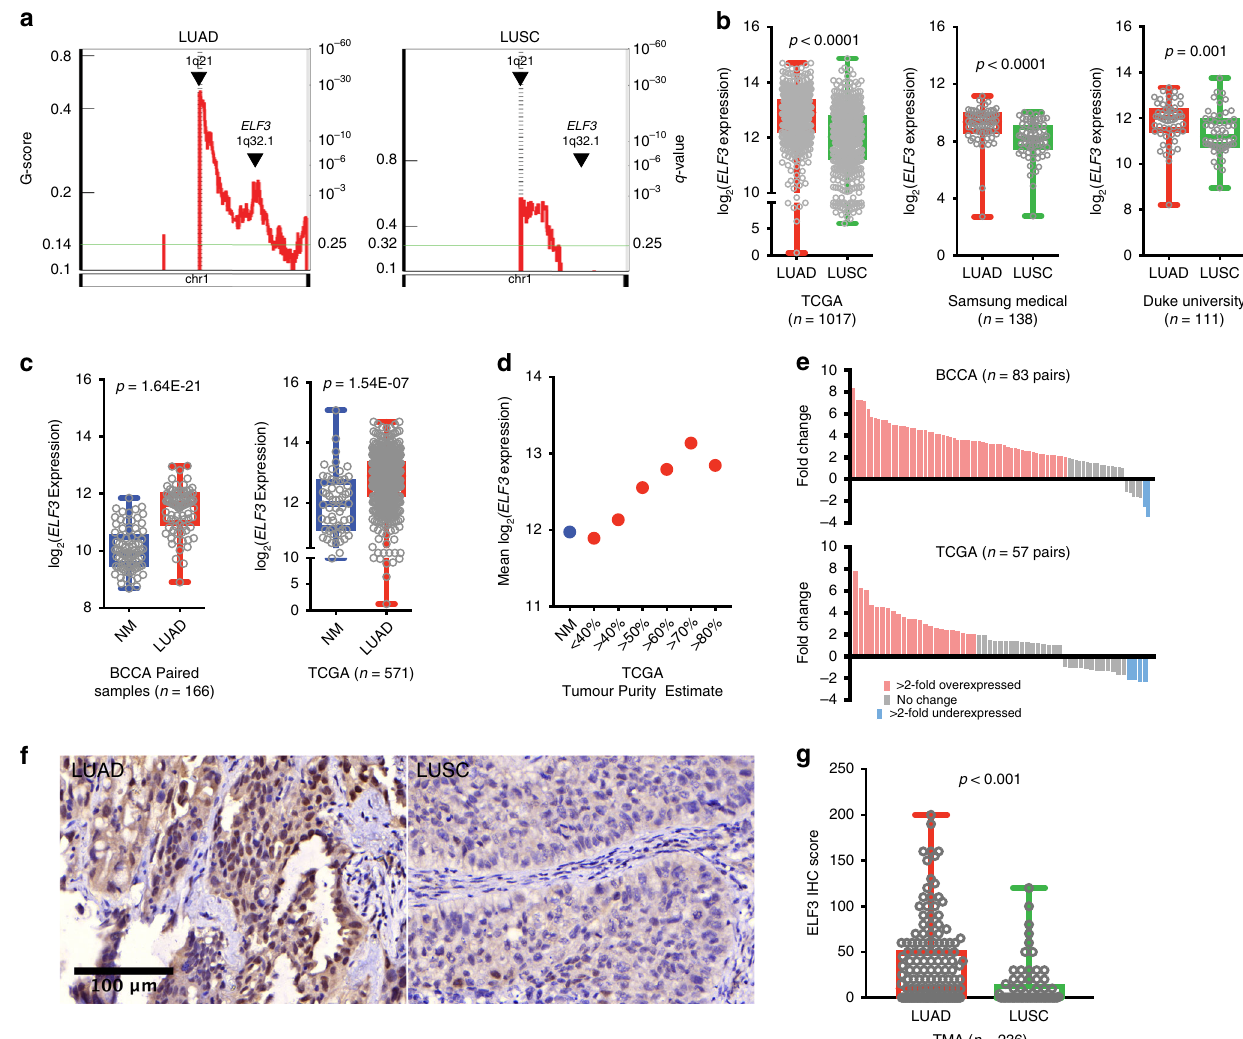
Fig. 1 ELF3 is located within a region of focal ampli fi cation in lung adenocarcinoma. a Comparison of signi fi cantly focally ampli fi ed regions on chromosome 1q in LUAD and LUSC. b Comparison of ELF3 expression between LUAD (red) and LUSC (green) in TCGA ( n = 1017), Samsung Medical Centre ( n = 138, GSE8894), and Duke University data sets ( n = 111, GSE3141) by Mann – Whitney U test. c Box and whiskers plots of log 2 ELF3 expression in 83 paired cases of non-malignant lung (blue) and lung adenocarcinoma (red) in the BCCA cohort (Wilcoxon sign-rank test), and unpaired cases of 58 non-malignant lung and 513 lung adenocarcinoma samples in the TCGA cohort (Mann – Whitney U test). d Mean log 2 ELF3 expression in non-malignant lung (blue) and in LUAD (red) grouped by purity estimate in the TCGA cohort 55 . e Distribution of ELF3 expression fold change in LUAD compared with paired non-malignant lung in the BCCA and TCGA cohort. f Representative ELF3 immunohistochemistry images from a tissue microarray of LUAD (left panel) and LUSC (right panel) (scale bar = 100 µ m). g Box and whiskers plots of ELF3 immunohistochemistry (IHC) score as determined by pathologist review ( n = 236, Mann – Whitney U test). Score was calculated by multiplying the percent of positive cells by the stain intensity ( + 1, + 2, + 3). In all box and whisker plots, center line represents the median, box bounds indicate the 25th and 75th percentiles, and whiskers extend from minimum to maximum. LUAD = lung adenocarcinoma, LUSC = lung squamous cell carcinoma, TMA = tissue